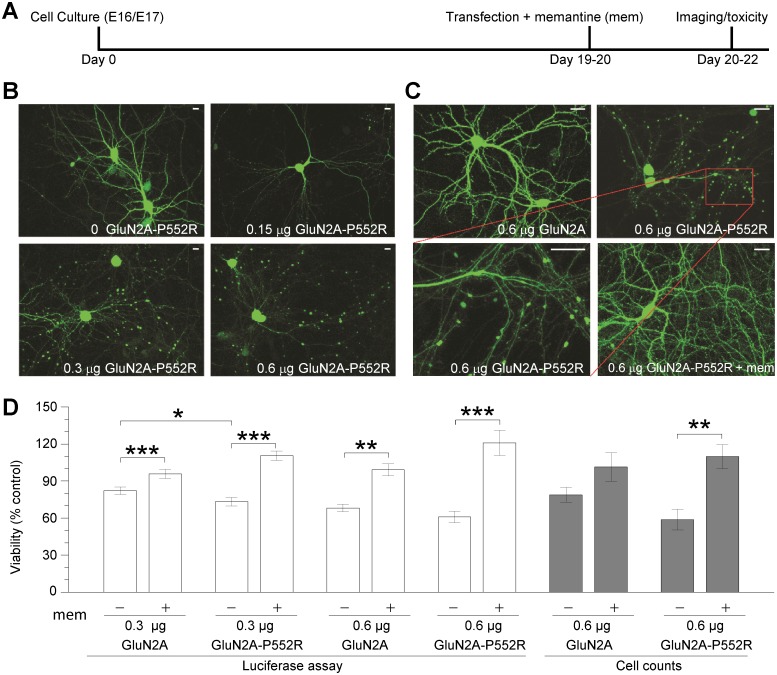
Neurotoxic consequences of GluN2A-P552R expression and rescue pharmacology.A, Schematic of experimental timeline indicates the relative dates of neuronal cell culture from embryonic day 16/17 (E16/17), transfection along with memantine/vehicle treatment, and toxicity studies (luciferase assays, cell counts, and confocal imaging). B, Confocal images of cortical neurons transfected with a GFP-expressing construct, with various concentrations of the human GluN2A-P552R-expressing plasmid illustrate the cell morphology. Images were acquired 24 h post-transfection at 20× magnification (scale bars 10 μm). C, Confocal images of cortical neurons transfected with GFP-expressing construct with either 0.6 μg cDNA per well (40% of total transfection cDNA) of WT GluN2A or GluN2A-P552R, the latter in the absence or presence of memantine (50 μM). Images were acquired 24 h post-transfection at 20× magnification, with the exception of the bottom left panel (40×), which highlights GluN2A-P552R-induced dendritic swelling and blebs (scale bar 10 μm). D, The mean cell viability values are shown as a percent of control. Luciferase assays: neuronal cultures were transfected with GFP-N1 plasmid (0.525 μg or 0.825 μg per well) luciferase cDNA (0.375 μg/well) for cell viability assaying, with varied concentrations (0.3 μg or 0.6 μg per well) of pCIneo-vector, WT GluN2A, or GluN2A-P552R cDNA (1.5 μg total DNA per well). Each transfection condition was performed in pairs, either supplemented with vehicle (–) or memantine (20 μM for 0.3 μg; 50 μM for 0.6 μg) treatment (+). Luciferase assays were performed 48 h following transfection and treatment. Experiments were performed in quadruplicate, and independent experiments were repeated (0.3 μg cDNA, n = 7; 0.6 μg cDNA, n = 8). Each condition was normalized to its relevant vector-transfected group to obtain relative viability values, expressed as % control. Data are mean ± SEM of viability (% control) for each condition (ANOVA/Bonferroni; *p <0.05, **p < 0.01, ***p < 0.001). Cell counts: Neuronal cultures were transfected with GFP-N1 plasmid for cell visualization, with either 0.6 μg pCIneo including vector, WT GluN2A, or GluN2A-P552R cDNA (40% of total transfection cDNA). Each transfection condition was performed in duplicate. Cell counts were performed 48 h post-transfection (Methods). Data are mean ± SEM of viability (% control) for each condition in 6 independent experiments. ANOVA/Bonferroni (**p < 0.01). See S9 Table for statistics.